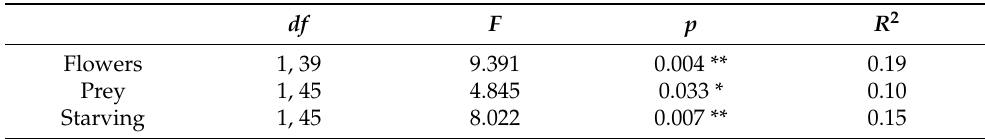
Figure 2. Linear regression of pre-oviposition time and the daily mean number of eggs laid per Harmonia axyridis female over 11 days for each diet (i.e., flowers, prey, and starving) plotted using the R package “ggplot2” [46]. See Table 3 for statistical results of the analysis. Table 3. Effect of pre-oviposition time on the daily mean number of eggs laid per female over 11 days for each diet (linear regression with log 10 (x + 1)-transformation prior to analysis, *: p < 0.05; ** p < 0.01). (See also Figure 2).